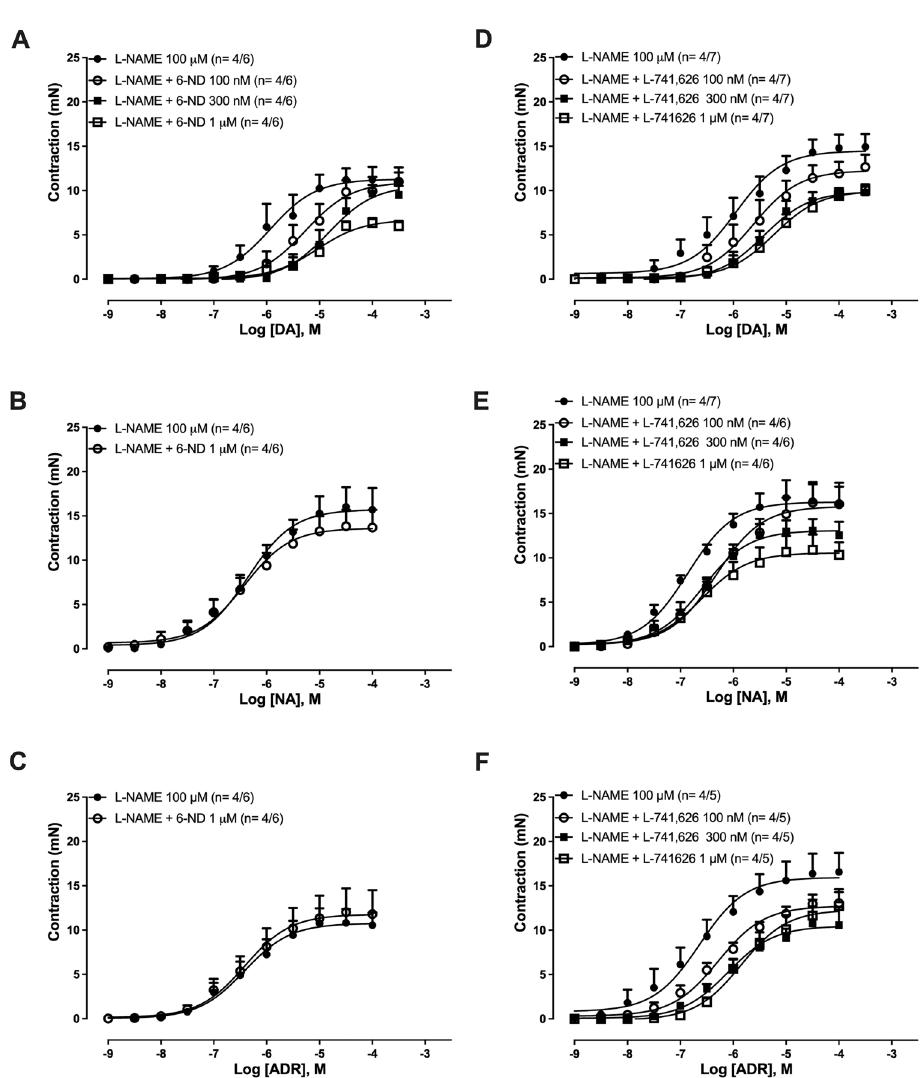
Figure 7. Effect of 6-nitrodopamine (6-ND) and the selective dopamine D 2 -receptor antagonist L-741,626 on dopamine-, noradrenaline-, and adrenaline-induced aortic contractions. Endothelium-intact aortic rings were all pre-treated with L-NAME (100 m M, 30 min), after which were incubated or not with either 6-ND (Panels A , B , and C ) or L-741,626 (Panels D , E , and F ). Concentration-response curves to dopamine (DA), noradrenaline (NA), and adrenaline (ADR) were then performed. The number of experiments (n) in each panel is reported as x/y, where x represents the number of animals and y the number of rings employed. Data are reported as means ±